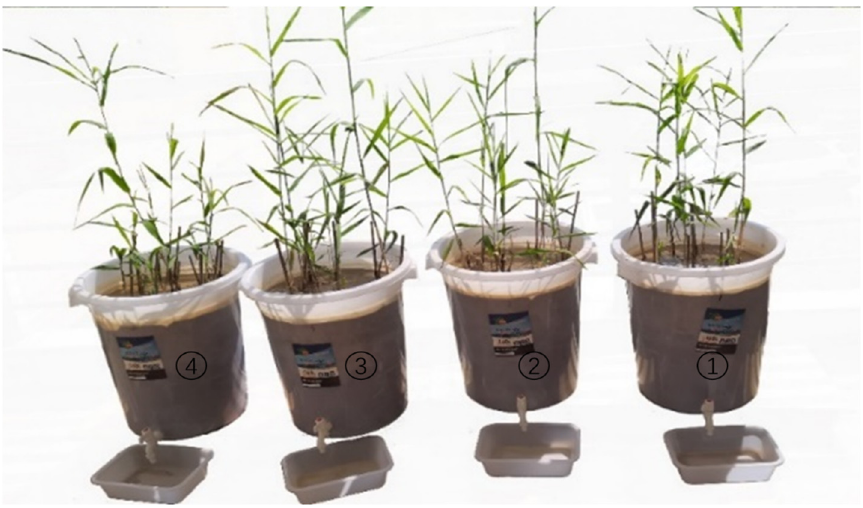
Figure 2. Simulated constructed wetland devices (from right to left, wetlands No. 1, 2, 3, and 4).